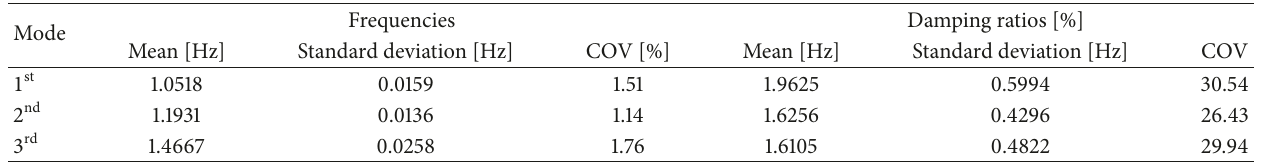
Figure 10: Evolution of the air temperature and wind velocity during the monitoring period and histories of identified fundamental frequencies. Table 2: Statistics of eigenfrequencies and damping